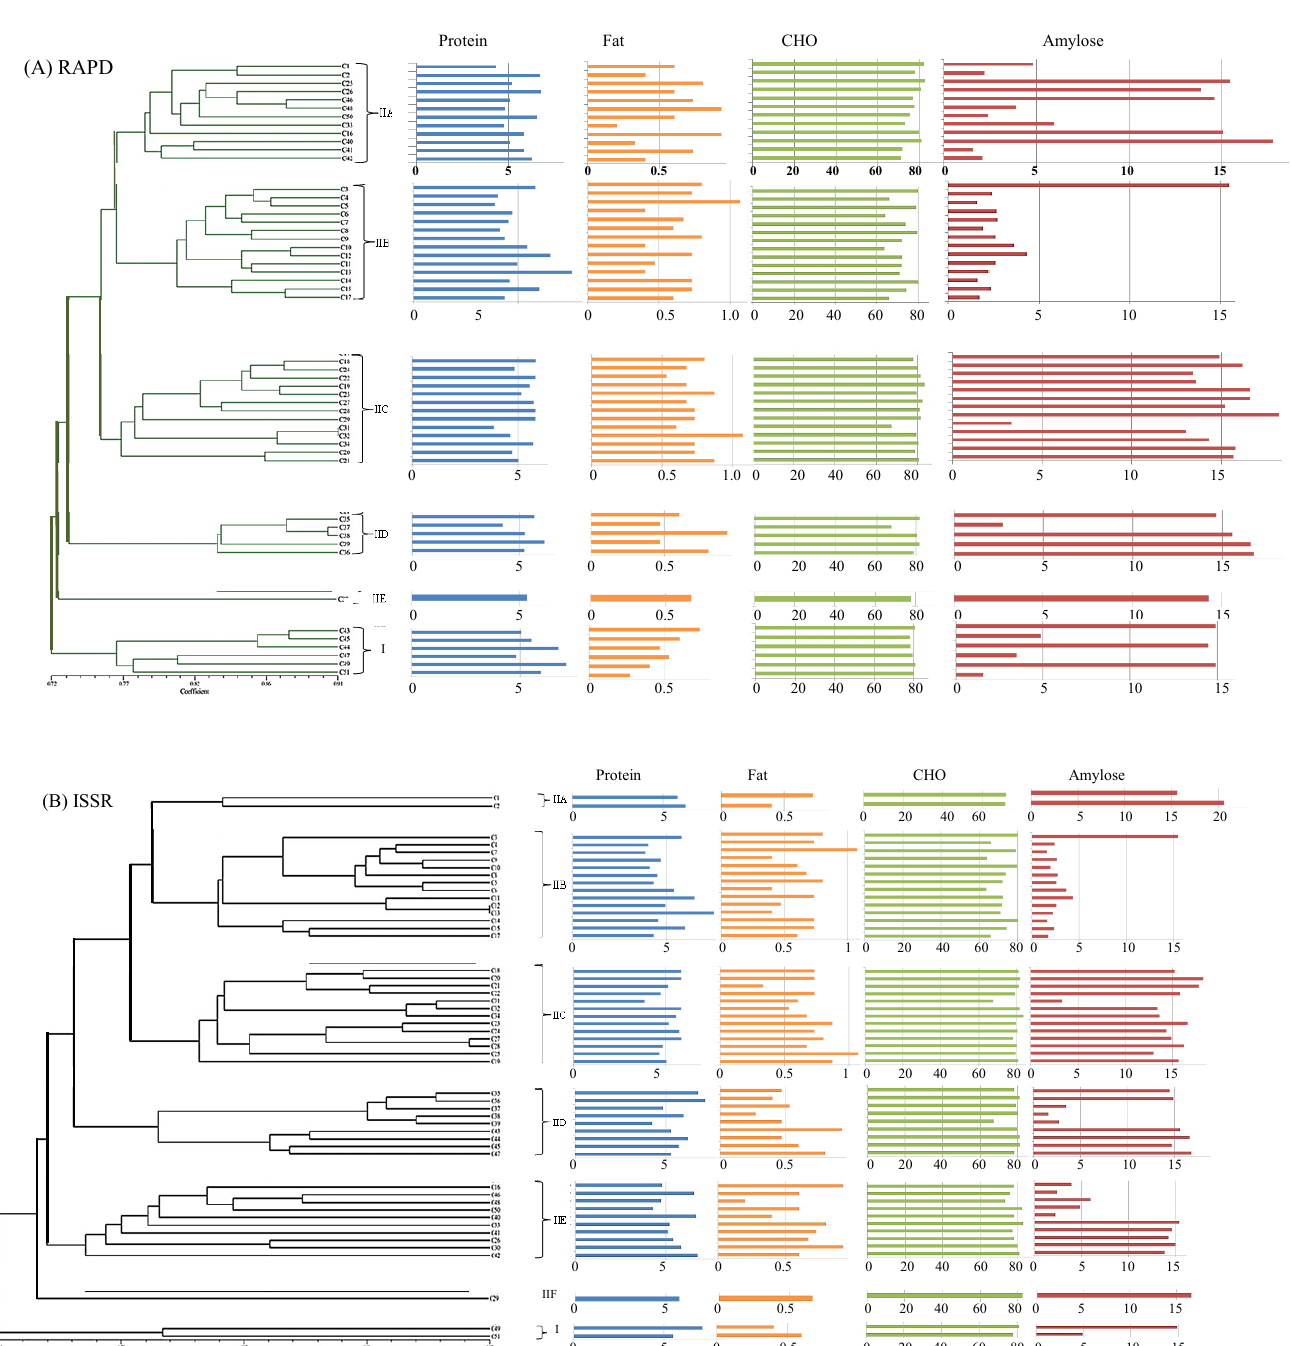
Fig. 2: UPMGA-based dendrograms depicting genetic relationships among 50 rice landraces and a commercial rice cultivar based on RAPD (A) and ISSR (B) profiles in comparison with some nutritional composition (Protein, Fat, CHO-Carbohydrate and